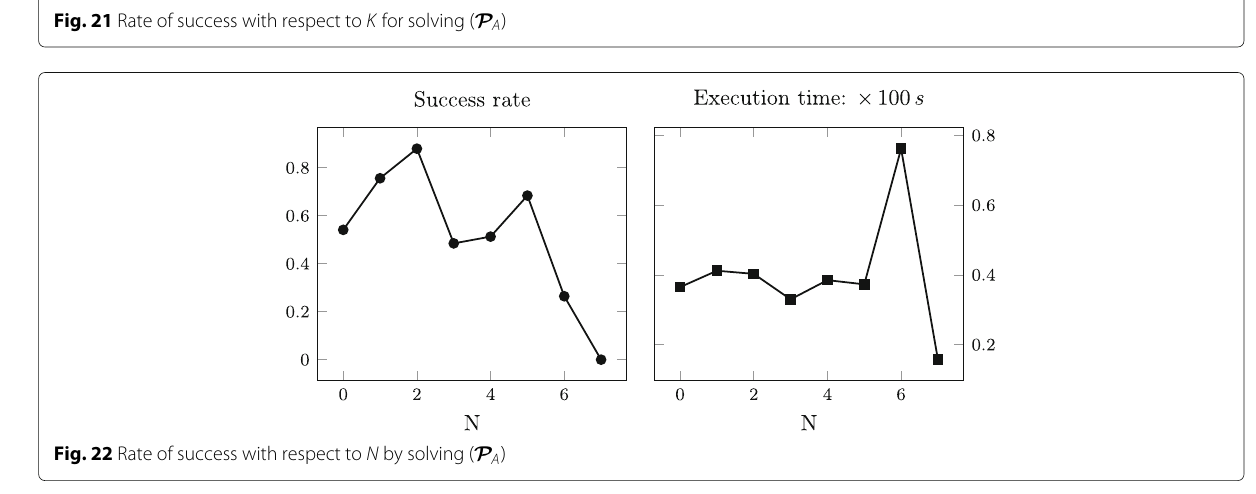
Fig. 22 Rate of success with respect to N by solving ( P A )